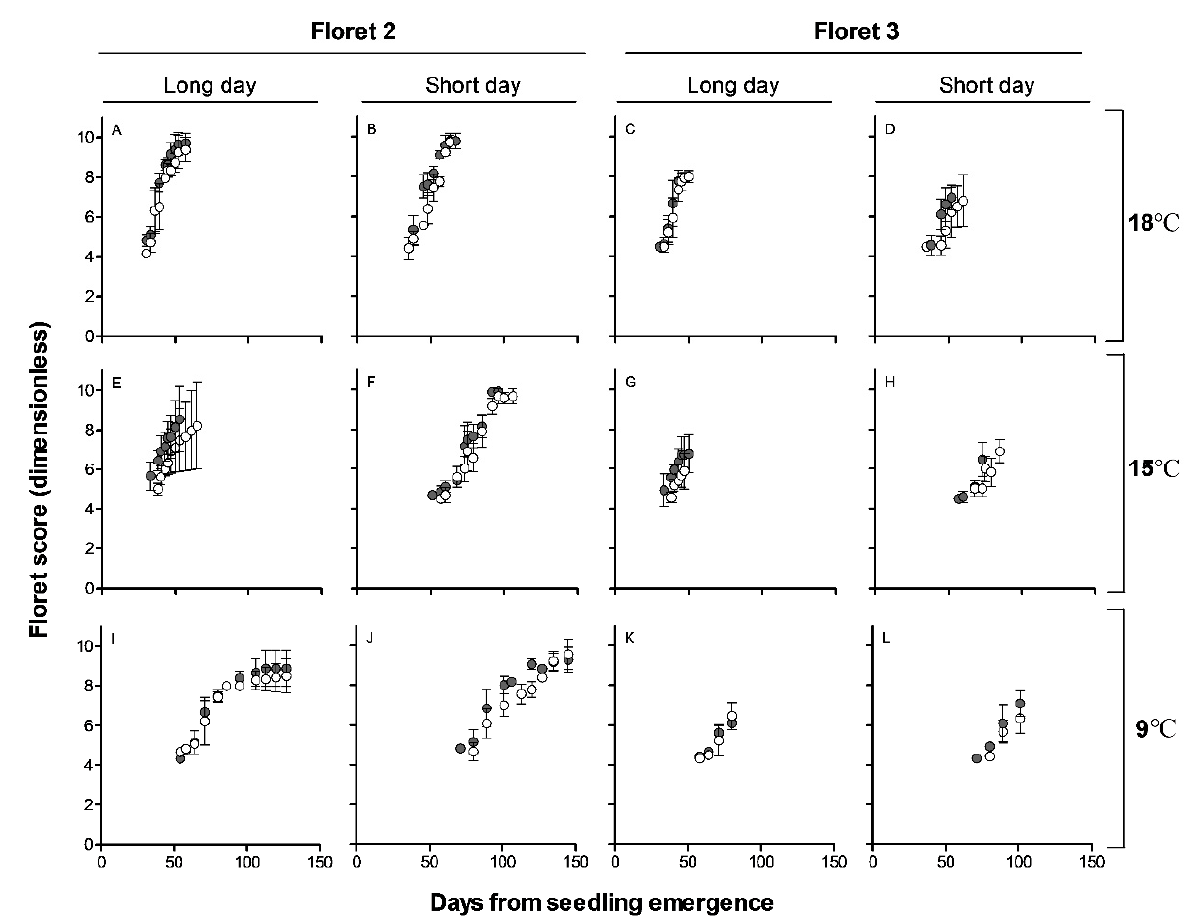
Figure 4. Relationship between floret development (floret score, scale proposed by Waddington et al. [44]) and days from seedling emergence for Eps-7D - late (open circles) and early (closed circles) for floret 2 ( A , B , E , F , I , J ) and floret 3 ( C , D , G , H , K , L ) under long and short days at 18 ( A – D ), 15 ( E – H ) and 9 ◦ C ( I – L ). The error bars are the standard error of means, considering the means of floret scores from apical, central and basal spikelets.